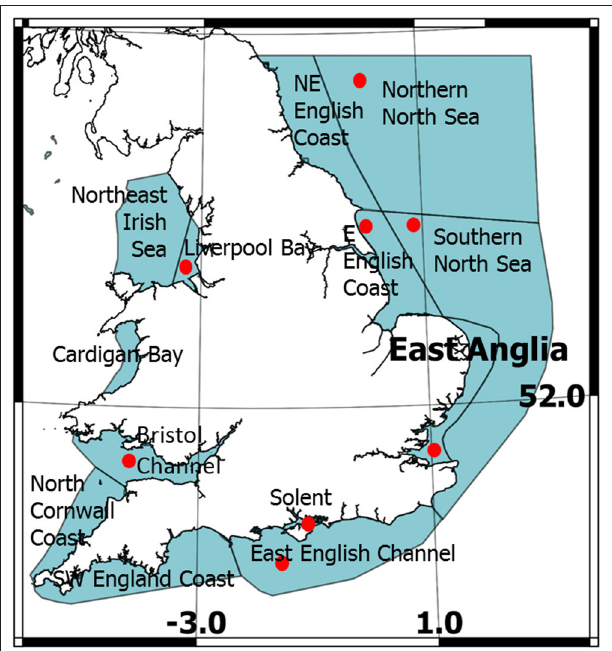
FIGURE 1 | Areas assessed in England and Wales for OSPAR COMP2. The red dots indicate areas where the full COMP2 was applied. East Anglia is highlighted for being the focus area of this